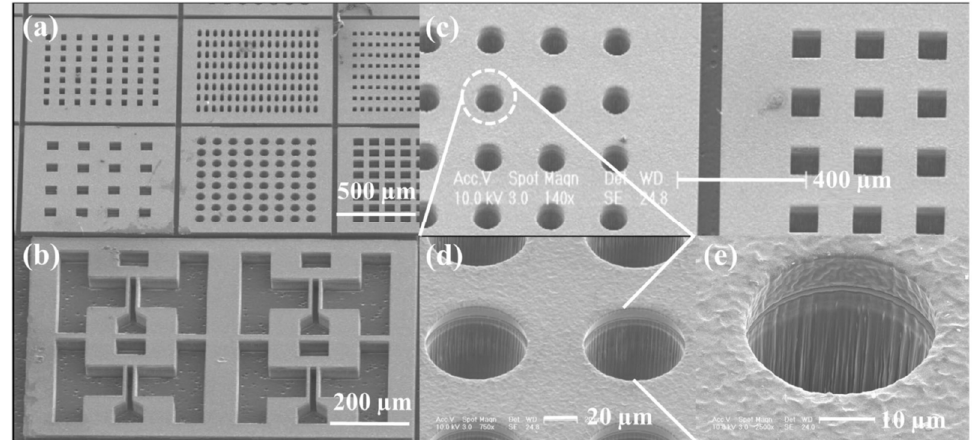
Figure 1. SEM images of various patterns formed on the SiC substrate by the ICP-RIE method: ( a ) Results of etching with using the masks with a different opening width: 35 µm, 25 µm, 20 µm, 100 µm, 70 µm and 70 µm (from the top left, row first); ( b ) vertically etched SiC with a well-etched sidewall profile; ( c ) circular and square etching patterns obtained for the mask opening width of 70 µm. Circular pattern enlarged five and ten times—in ( d , e ), respectively. Reprinted with permission from Ref. [23]. Copyright 2021 Sci. Rep